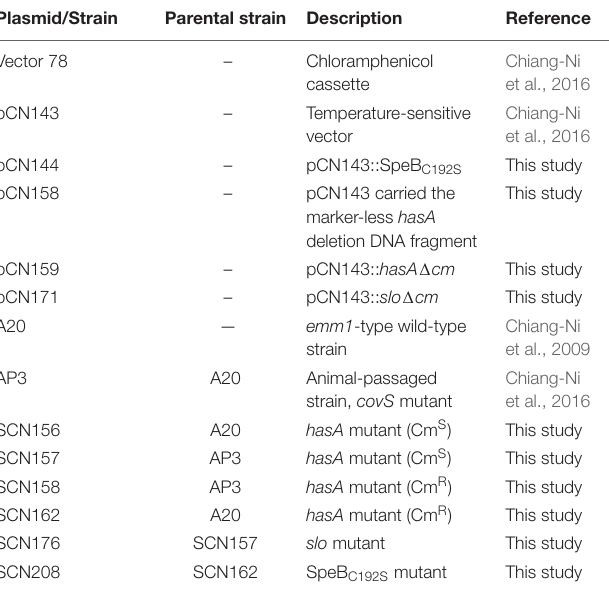
TABLE 1 | Plasmids and bacterial strains used in this study. Plasmid/Strain